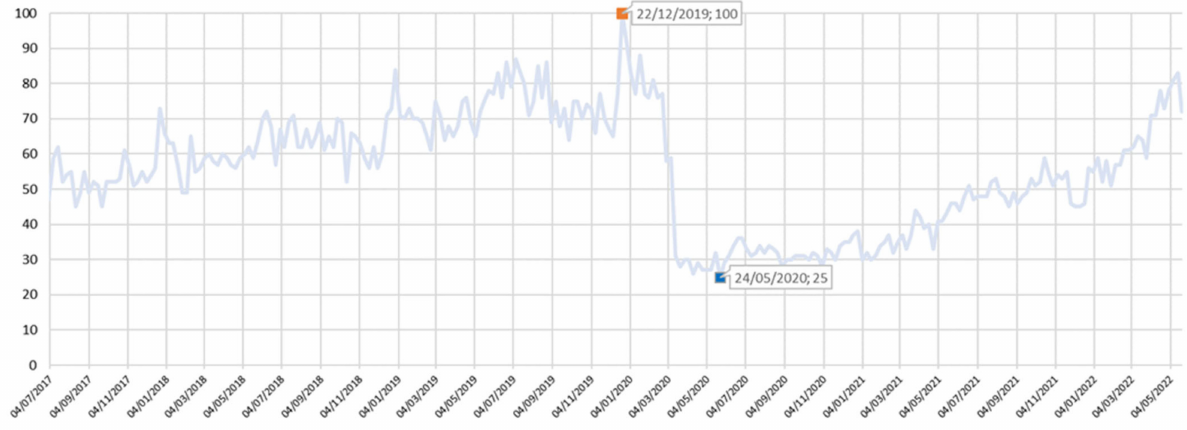
Figure 1. Interest over time in solo travel Google